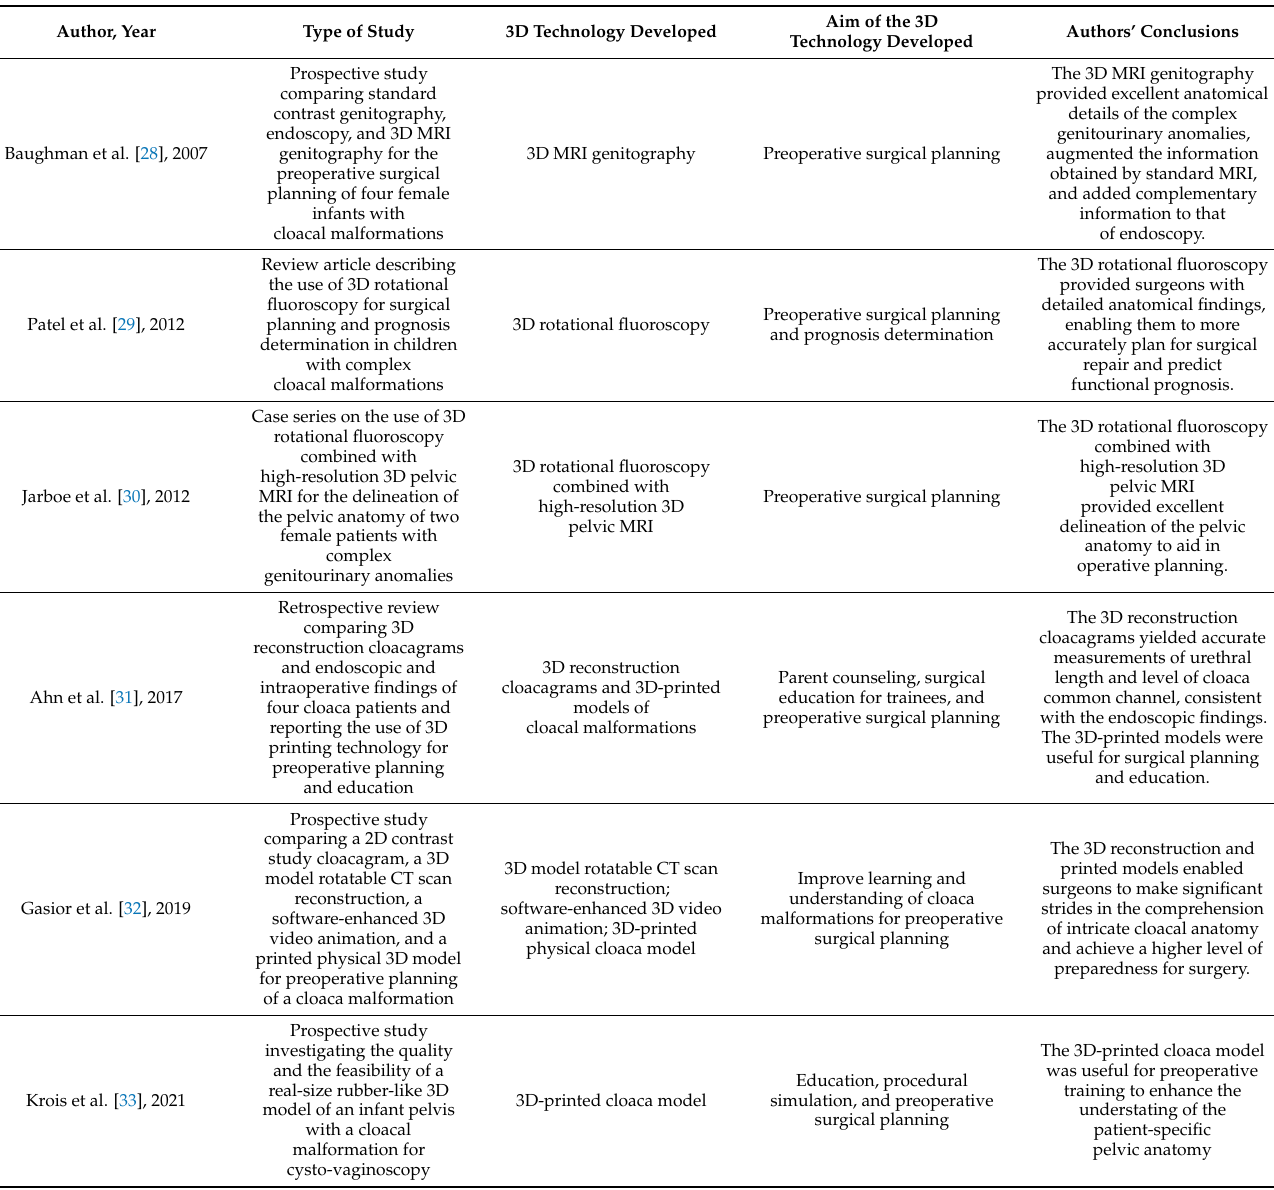
Table 2. Selected scientific article focusing on 3D reconstruction technologies and printing techniques for cloaca